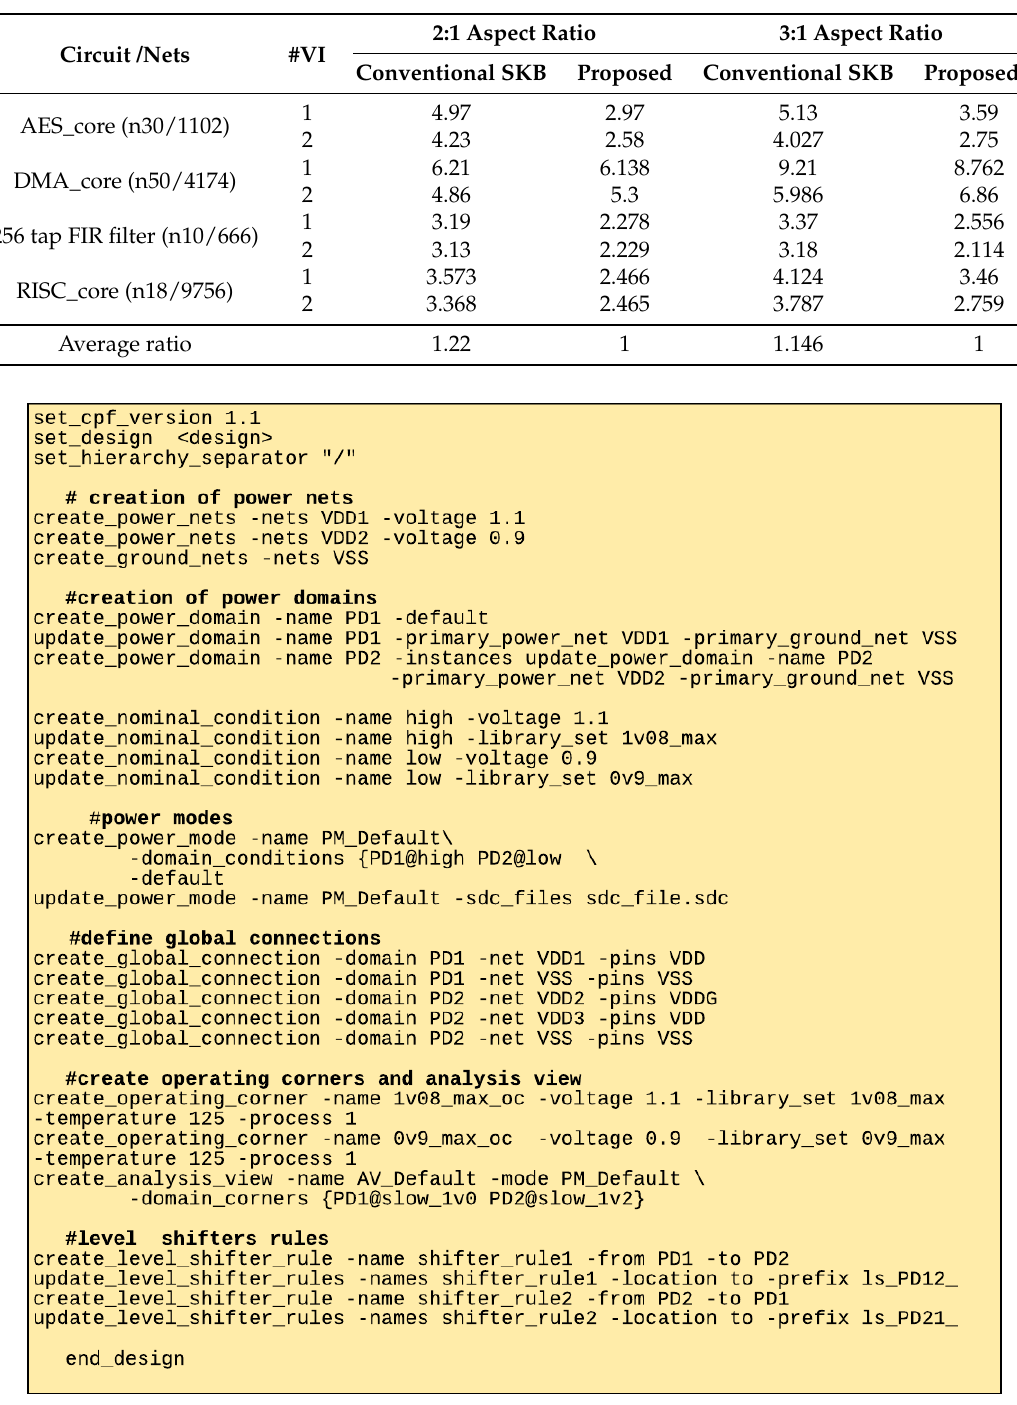
Table 6. Comparison of power for simultaneous fixed outline floorplanning and voltage island floorplanning with conventional SKB floorplanning.